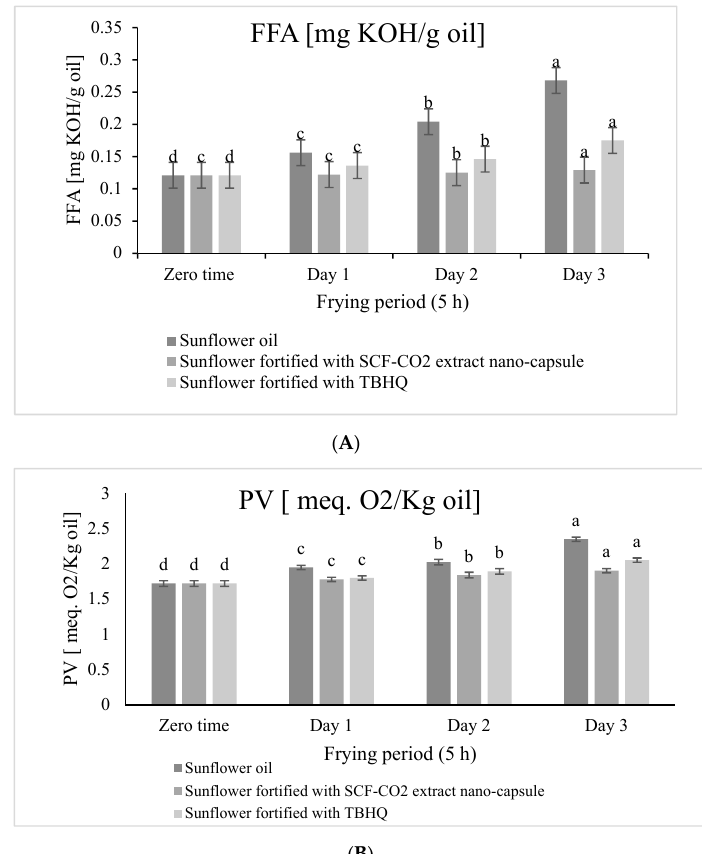
Figure 6. Changes of FFA ( A ) and PV ( B ) of fortified sunflower oil compared with control samples. I %: Relative Increase % of FFA or PV after 15 h of frying at 3 days; a-d different superscripts in a column were significantly different ( p < 0.05) values are mean ± S.D. for triplicate determinations.